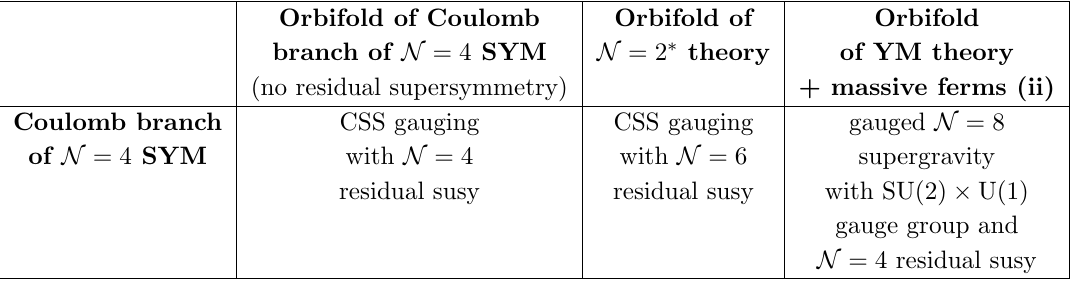
Table 1 . Double-copy constructions of gravitational theories from the theories discussed in sec- tion 3, to be discussed in the next